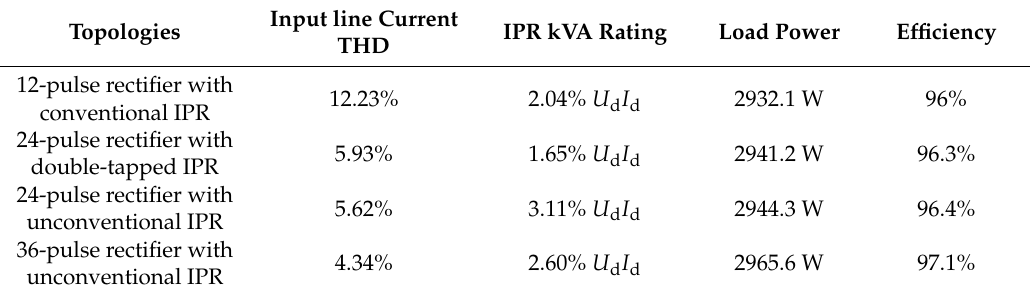
Figure 12. Waveforms of input line currents. ( a ) Conventional 12-pulse rectifier. ( b ) 24-pulse rectifier with double-tapped IPR. ( c ) 24-pulse rectifier with unconventional IPR. ( d ) Proposed 36-pulse rectifier with unconventional IPR. Table 2. Comparison of the Proposed Rectifier with Other MPRs.